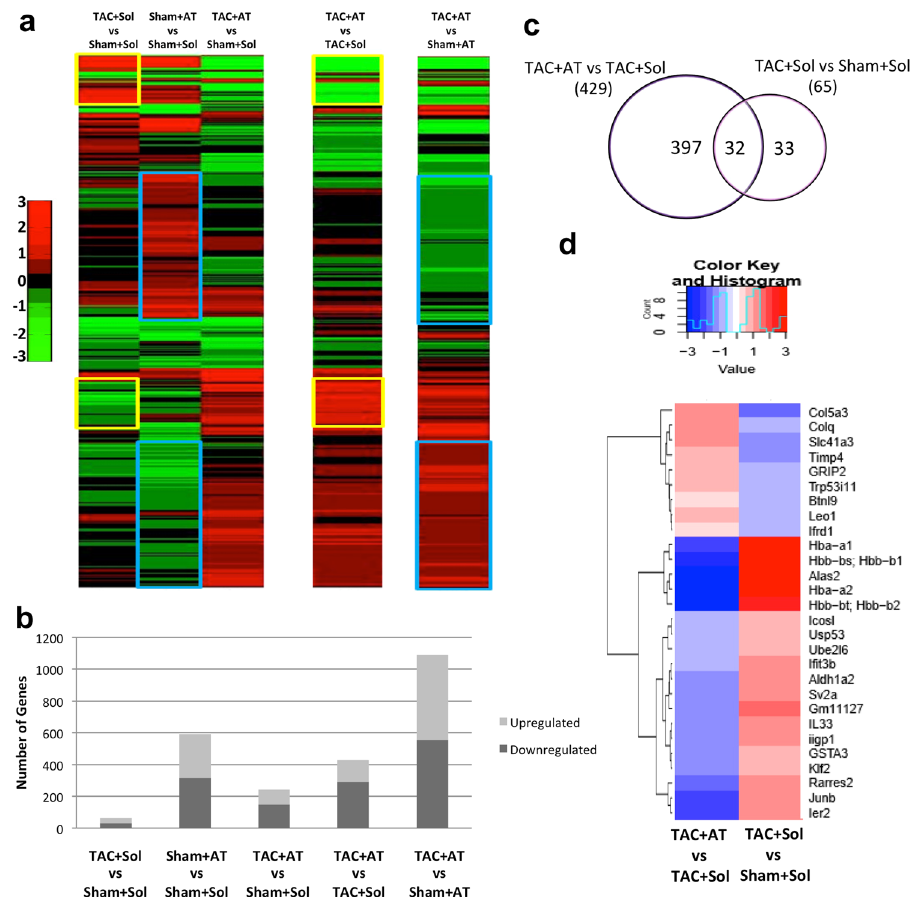
Figure 2. Changes in gene expression caused by aortic constriction is reversed by atenolol treatment. Four weeks after Atenolol treatment of TAC or Sham operated mice, RNA-seq analysis of whole tissue from the left ventricle was performed. Similar tissue was collected the Solvent control group (n = 3 per group). ( a ) A heatmap depicting changes in gene expression of 1571 protein coding genes. Genes are ordered based on hierarchical clustering. Genes up- or down-regulated by TAC alone, relative to control (leftmost column; yellow box). Effects of β -blocker (2 nd leftmost column; blue box). ( b ) The total number of up and downregulated genes in each condition. ( c ) A select group of genes (32) were differentially regulated in both the TAC + Sol vs Sham + Sol and TAC + AT vs TAC + Sol conditions. ( d ) A heatmap depicting the Fold Change values of TAC + AT vs TAC + Sham and TAC + Sol vs Sham +